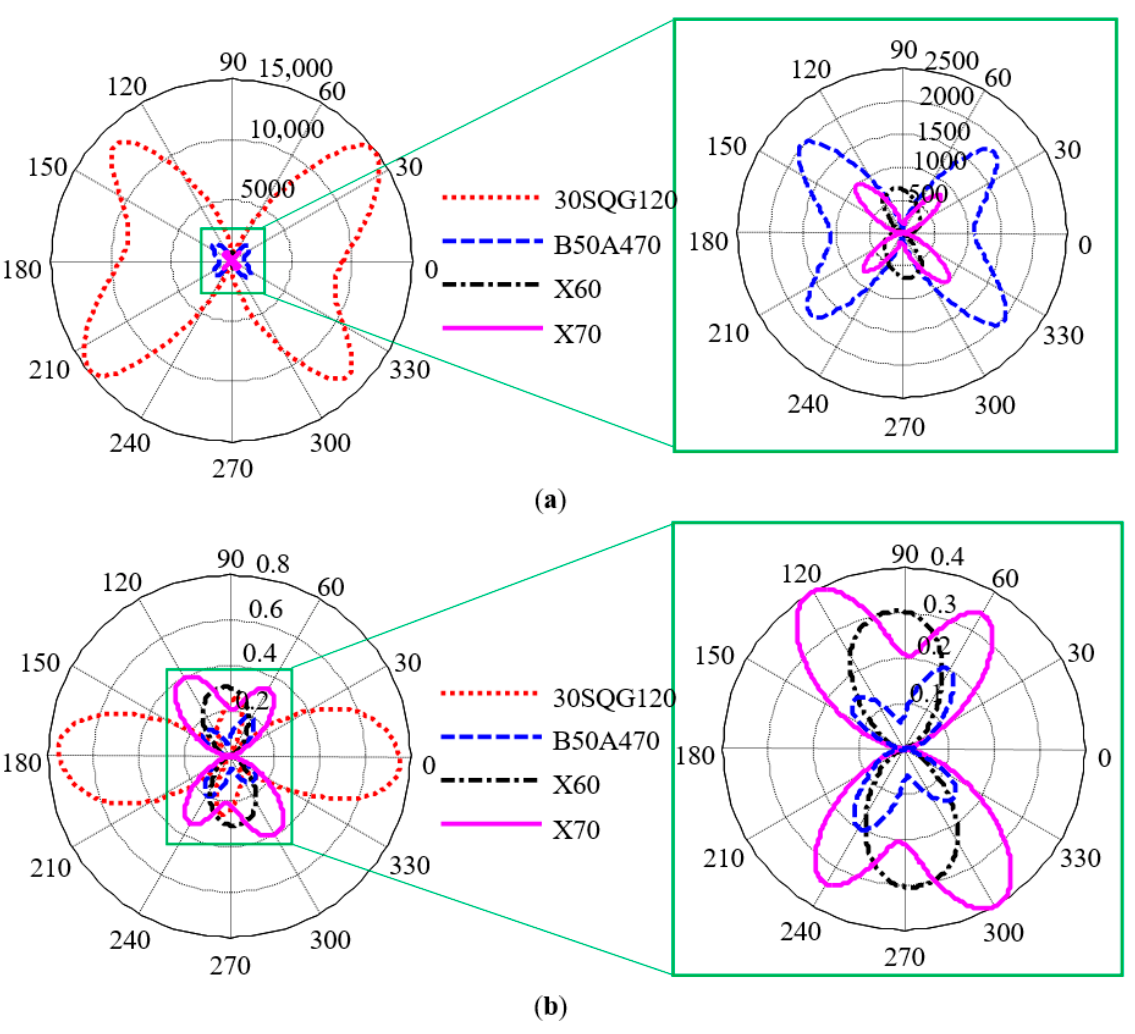
Figure 15. Comparison of experimental results and simulation results under fixed detection parameters: ( a ) simulation results and ( b ) experimental results.